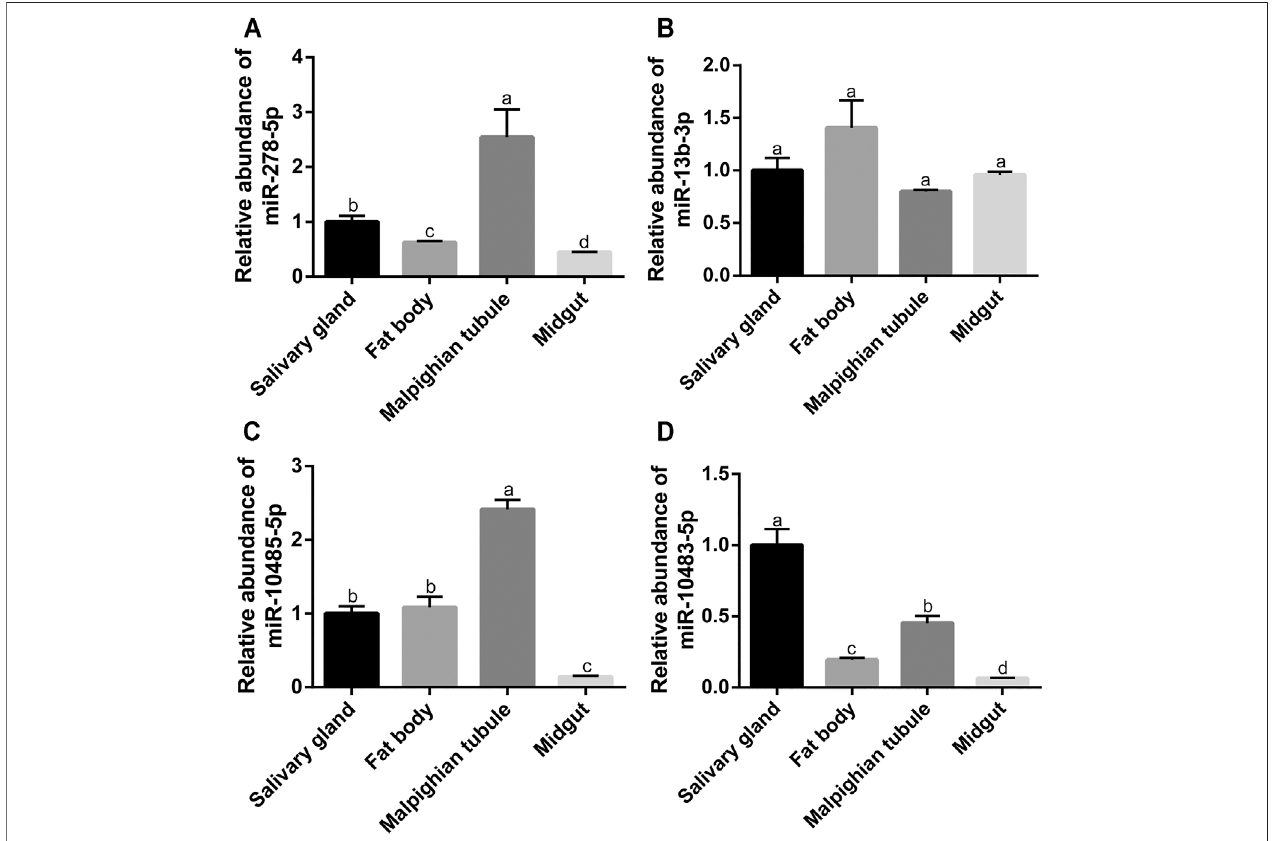
FIGURE7| ExpressionoffourmiRNAsindifferenttissuesof S.frugiperda . (A – D) AnalysisofthemiR-278-5pexpressionatthedifferenttissuesofthesalivarygland, fat body, Malpighian tubule,and midgut. Theletters a,b,c,d,e,and frepresent signi fi cantdifferences( p < 0.05).Results areshown astheaverage ± standard error(SE).